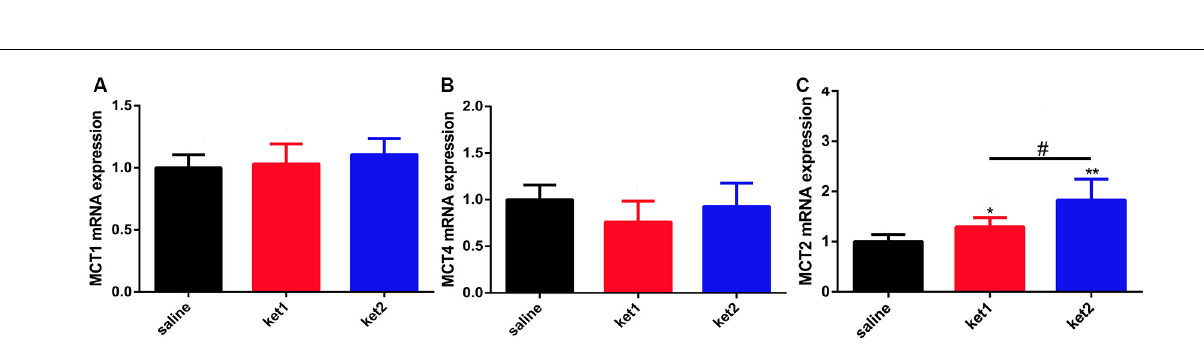
FIGURE 6 | Changes of hippocampal MCT1, MCT4 and MCT2 mRNA levels after 6 months of ketamine administration in different groups. (A) No significance of MCT1 mRNA expression levels were seen in three groups. (B) Significant increase of MCT2 mRNA expression levels were seen in ket2 and ket1 group comparing with control group ( F (2,33) = 3.709, * p < 0.05, F (2,33) = 3.461, # p < 0.05 and F (2,33) = 5.758, ** p < 0.01, respectively). (C) No significance of MCT4 mRNA expression levels were seen in three groups (saline n = 12, ket1 n = 12, ket2 n =